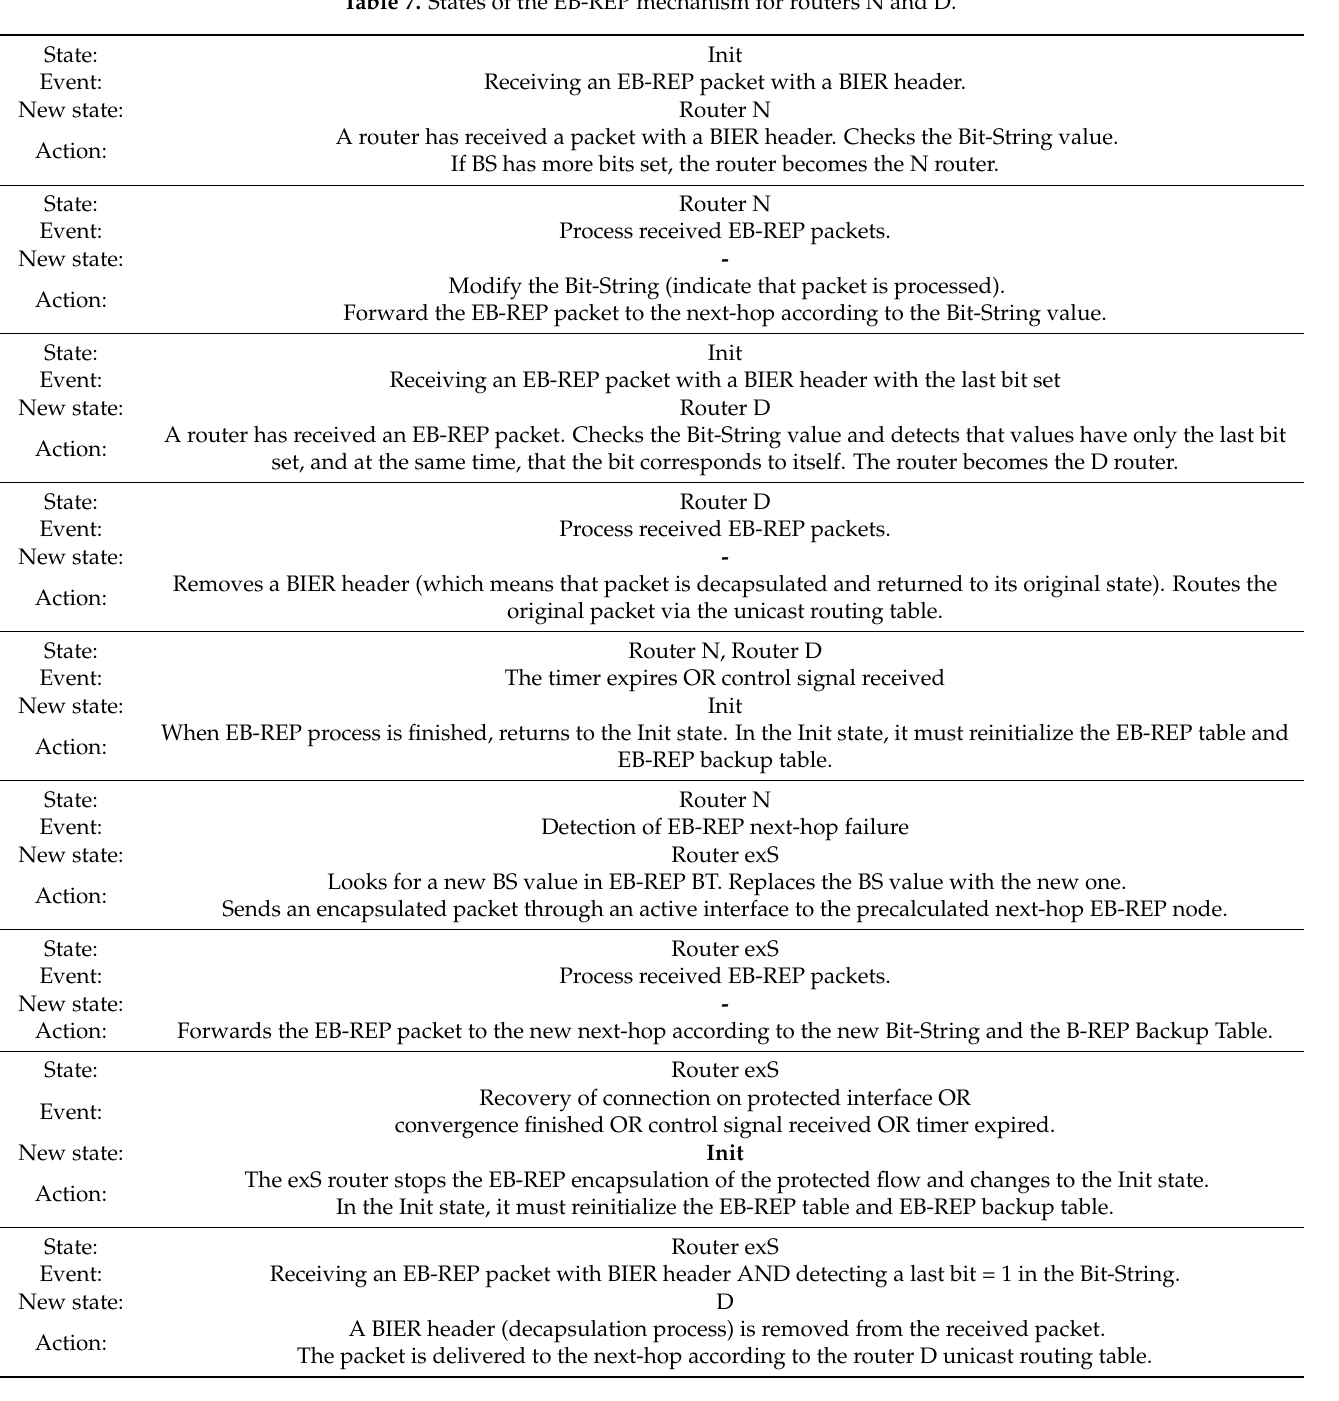
Table 7. States of the EB-REP mechanism for routers N and